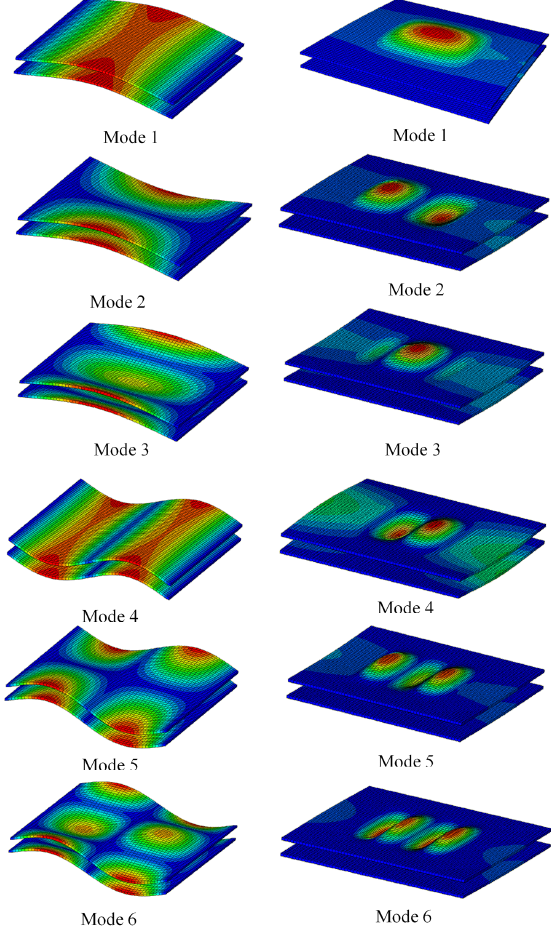
Figure 7: Eigenmodes between intact and debonded model (30%).